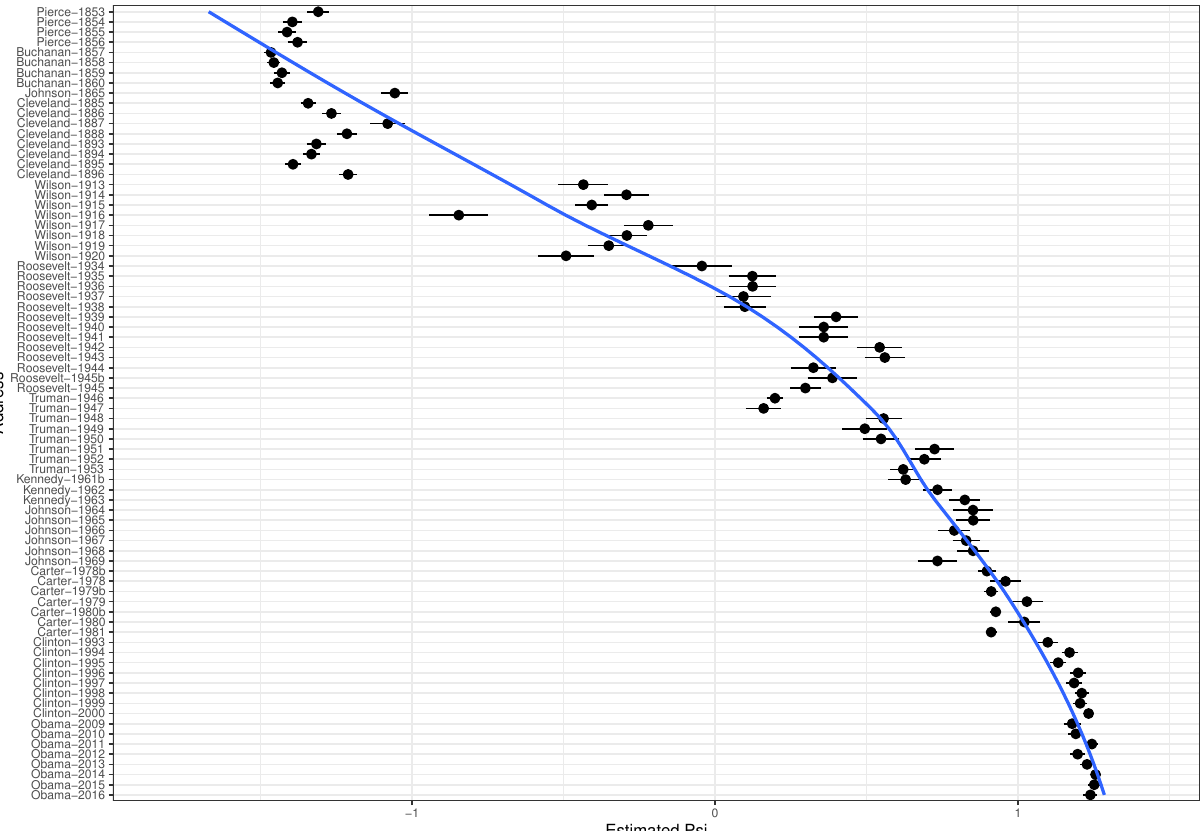
Figure 2. Wordfish scores for Democratic presidents (blue line is the smoothed Loess